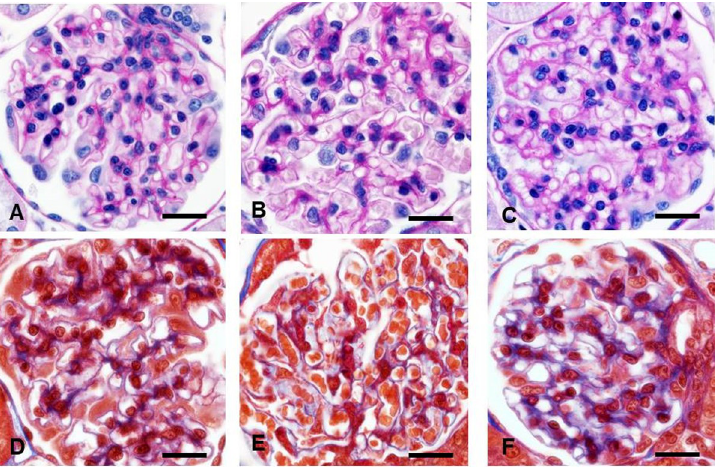
Fig 4. Representative images of hypertensive glomerulopathy in rats. A, D Control rats. B, E Spontaneously hypertensive rats. Hypertrophic glomeruli are distinguished with numerous enlarged capillary lumens. C, F The nonclipped kidney. Hypertrophic glomeruli had no visible lesions except enlarged capillary loops and more collagen that distributed along the glomerular basement membrane. Hyalinosis and segmental sclerosis was absent in all models. A-C —periodic acid-Schiff; D-F Masson trichrome staining. x600.